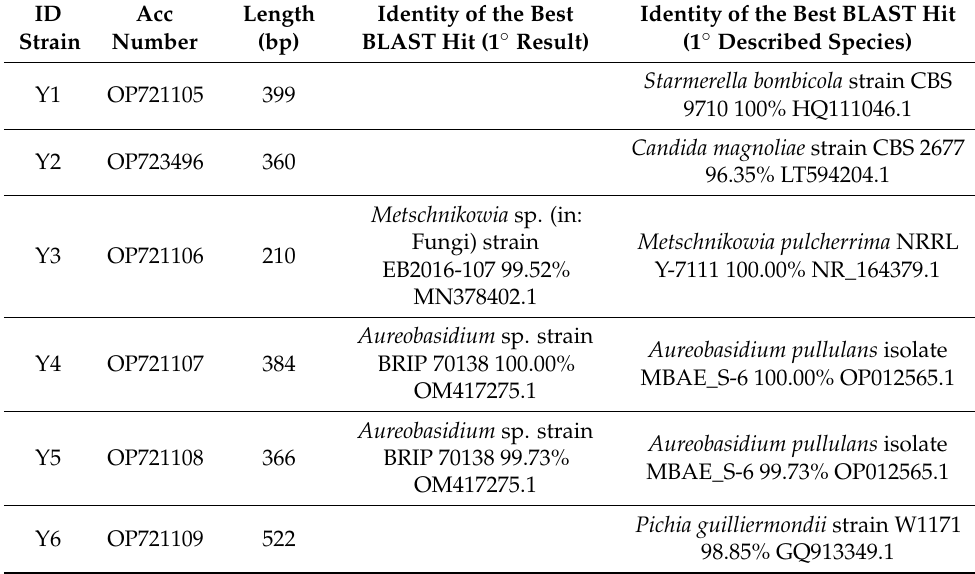
Table 2. Taxonomic affiliation of sequenced strains according to NCBI Blast analysis. Accession numbers of sequences are